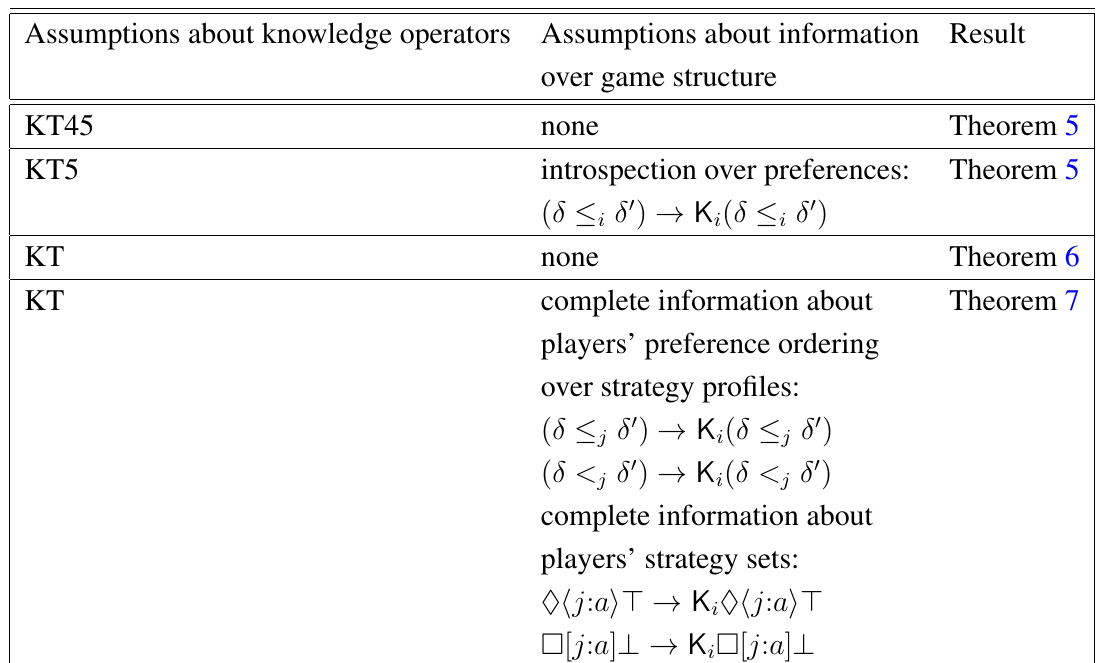
Table 1. Some sufficient conditions for Theorems 5, 6,